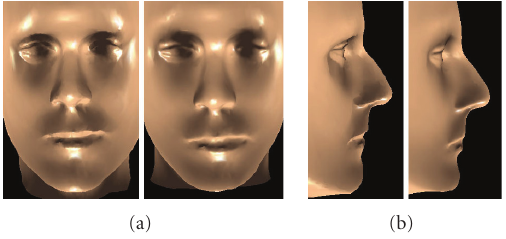
Figure 12: Comparison of an original model (left in each view) and synthesized model (right in each view) in cross